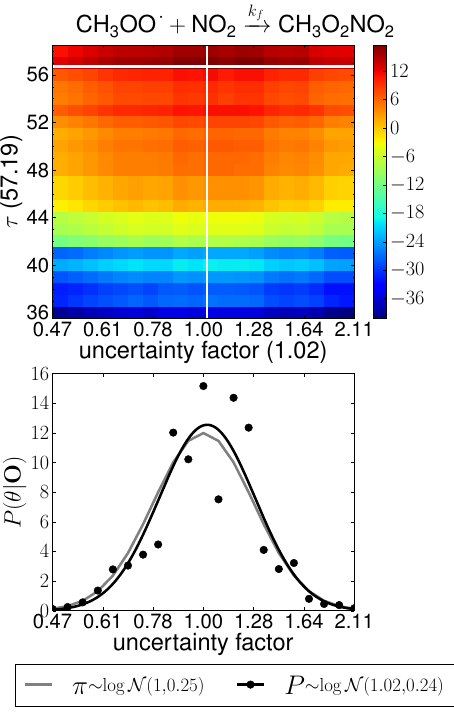
q Fig. A6. Same as Fig. A1 for the CH 2 O+ hν +NO 2 → CH 3 O 2 NO 2 Fig. A6. Same as Fig. A1 for the CH 2 O+ hν reaction.